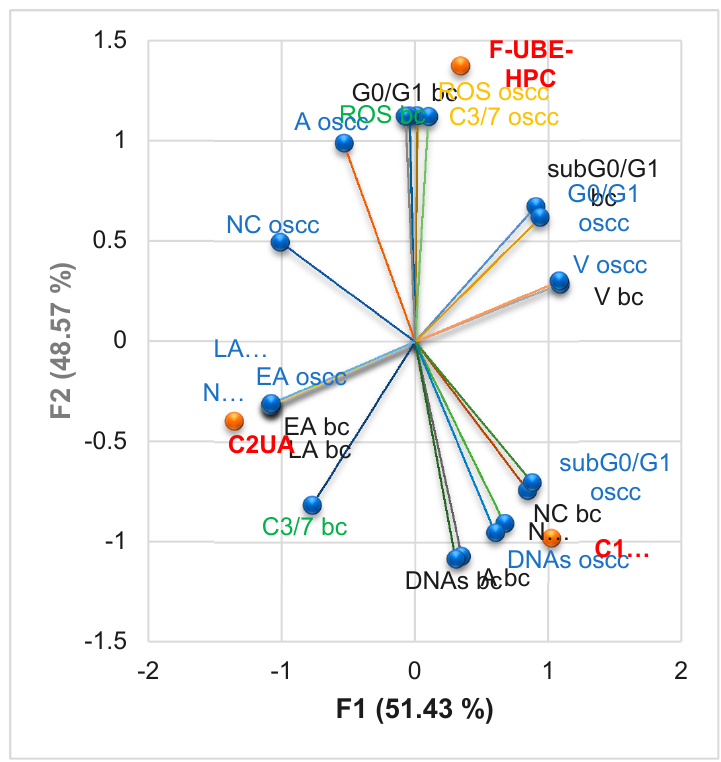
Figure 15. PCA-Correlation biplot between mechanisms (caspase 3/7 activity and cellular oxidative stress) and processes induced by F-UBE-HPC and both controls (C1-DMSO and C2UA) in normal blood cells (bc) and CLS-354 tumor cells (oscc). V—viability; EA—early apoptosis; LA—late apoptosis; N—necrosis; NC—nuclear condensation; A—autophagy; DNAs—DNA synthesis; subG0/G1—apoptotic cell fraction http://www.icms.qmul.ac.uk/flowcytometry/uses/apoptosis/dnafragmentation/ (accessed on 11 July 2022); G0/G1—cell cycle arrest in G0/G1; ROS—oxidative stress; C3/7—caspase 3/7 activity; F-UBE-HPC—bioadhesive oral film loaded with U. barbata dry ethanol extract.